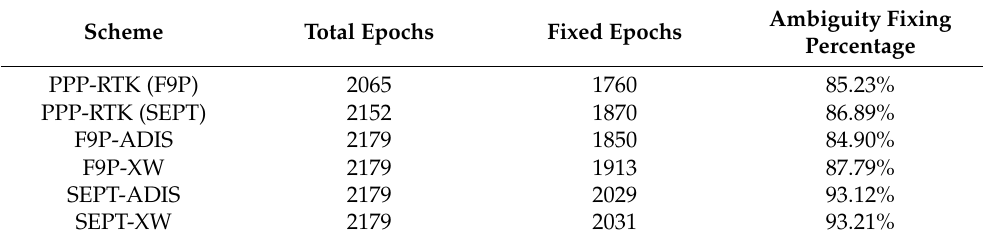
Table 7. Ambiguity-fixing percentage under different schemes in experiment C.